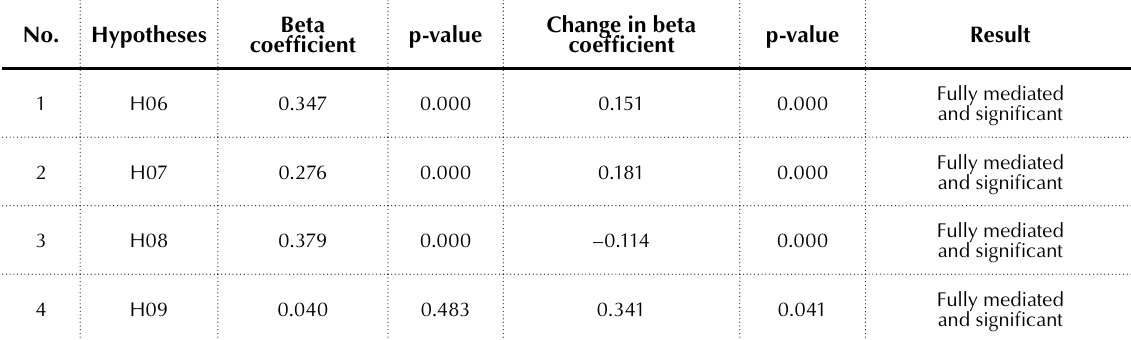
Table 5. Moderating